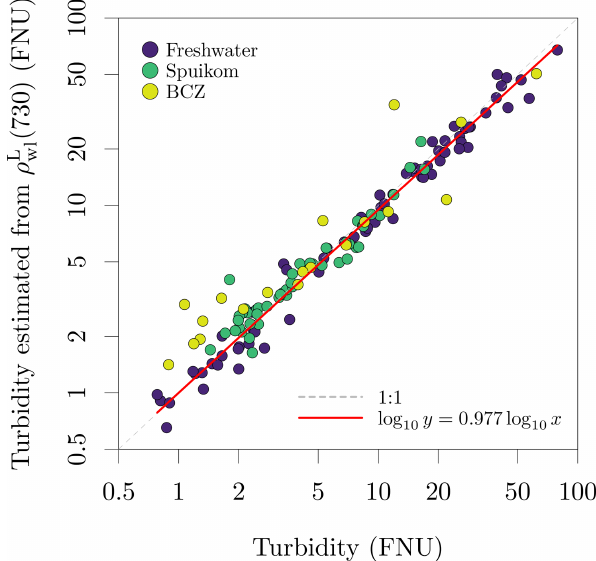
data quality by comparing the turbid- Figure 9. Assessment of ρ L wl ity estimated from reflectance using the algorithm of Nechad et al. (2010) to the measured turbidity.